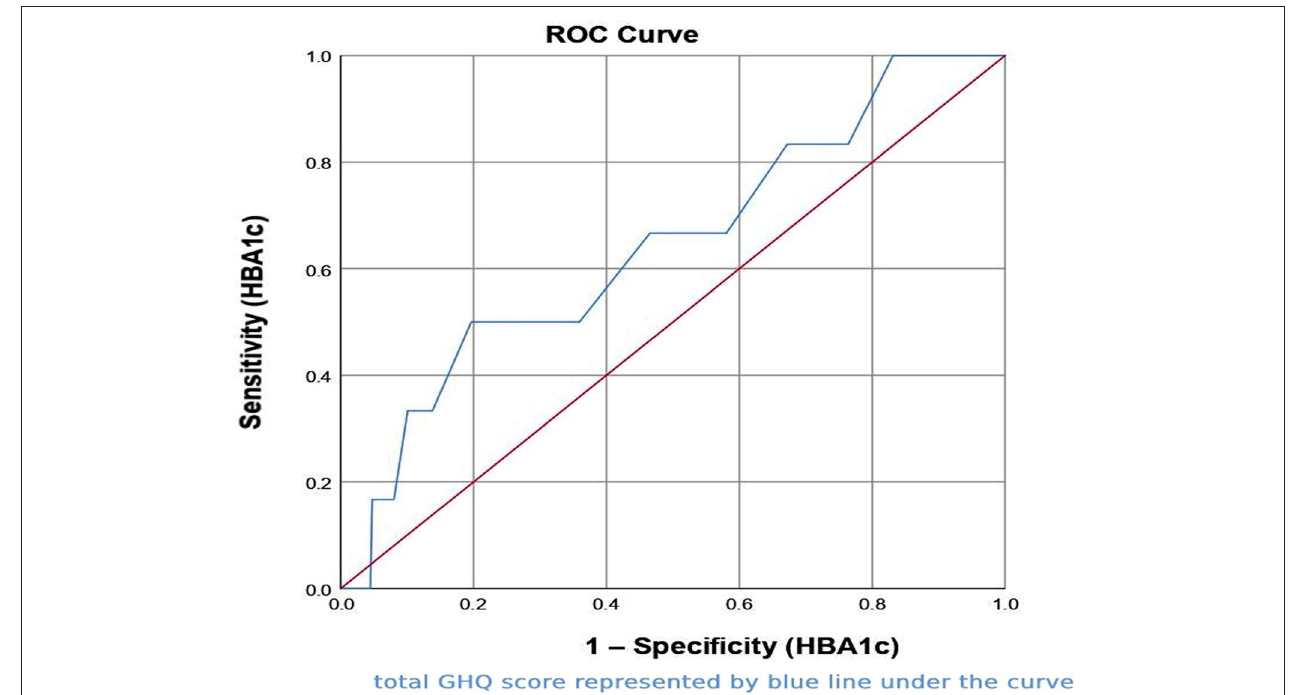
FIGURE 1 | Receiver operating characteristic (ROC) curve for total general health questionnaire (GHQ)-12 score against HbA1c (as the test result